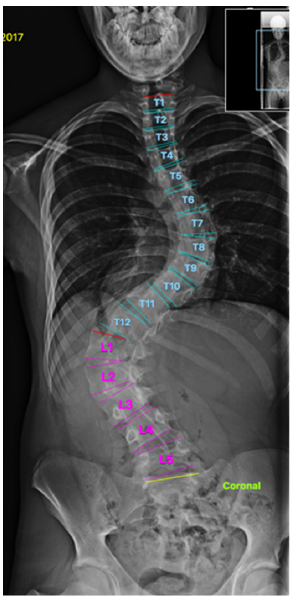
Figure 6. ( A ) Pre-op TK: − 7.3 degrees (hypokyphosis), predicted TK: 20 degrees, pre-op MT Cobb: 98 degrees. ( B ) Templating using Surgimap and patient-specific template. ( C ) Post-op X-ray at 6 months. Achieved TK: 26 degrees, MT Cobb Post-op: 30 degrees.